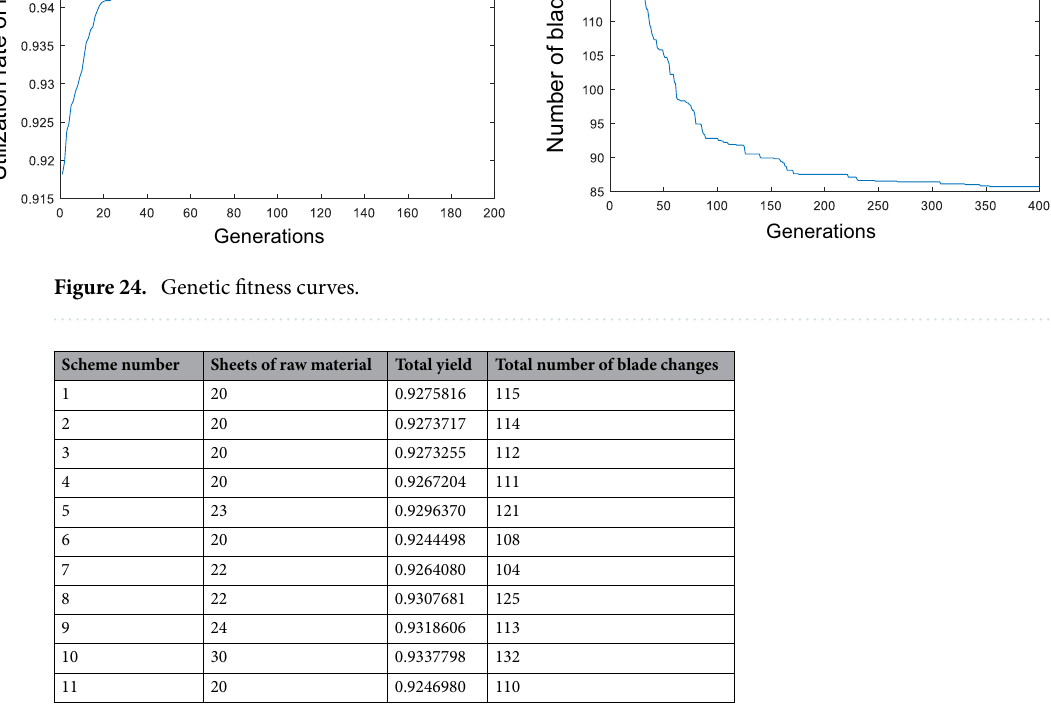
Table 4. Pareto-optimal solution